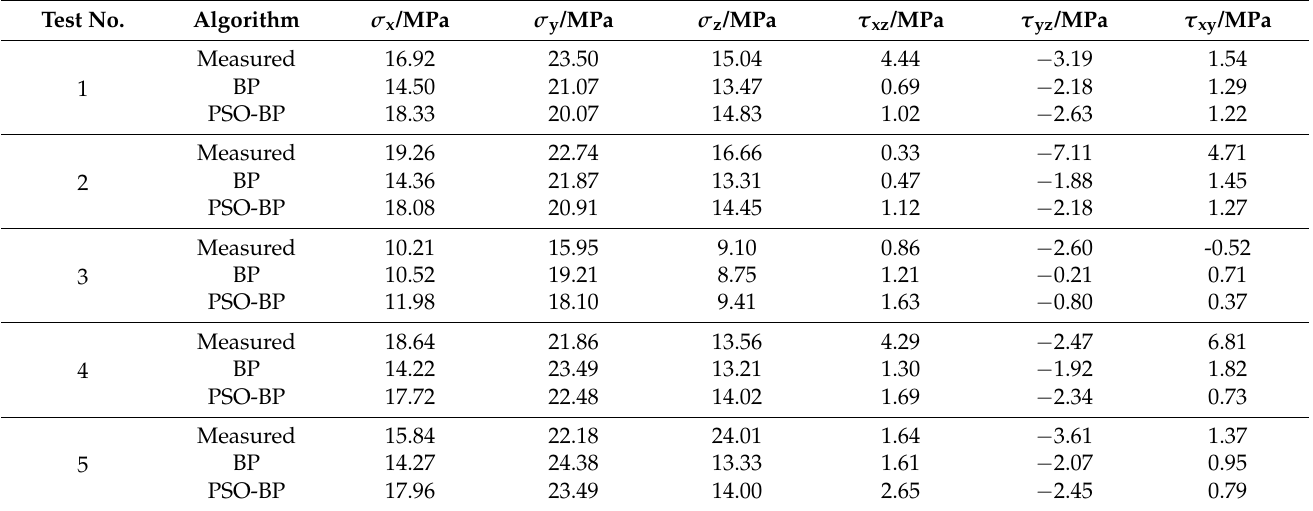
Table 6. Computational stress components at test points. A comparison of the computational stress of the two back analysis